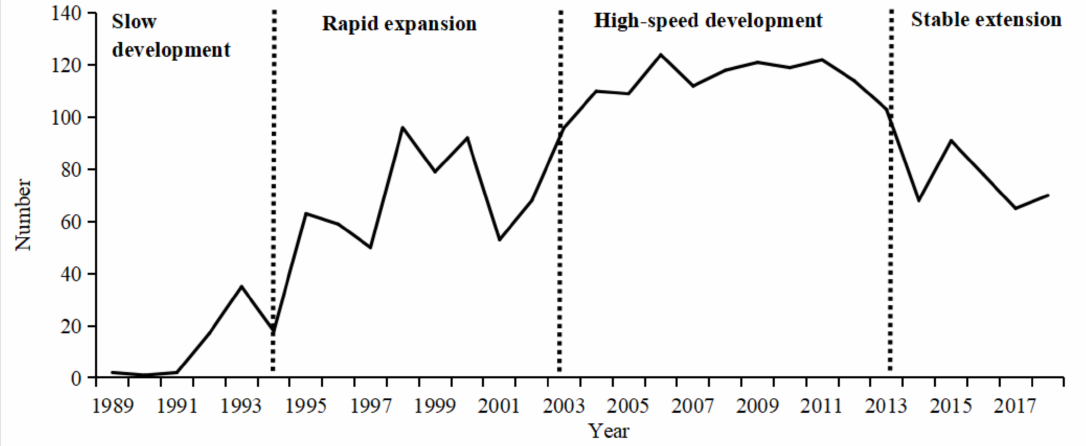
Figure 2. Number of new communities over the